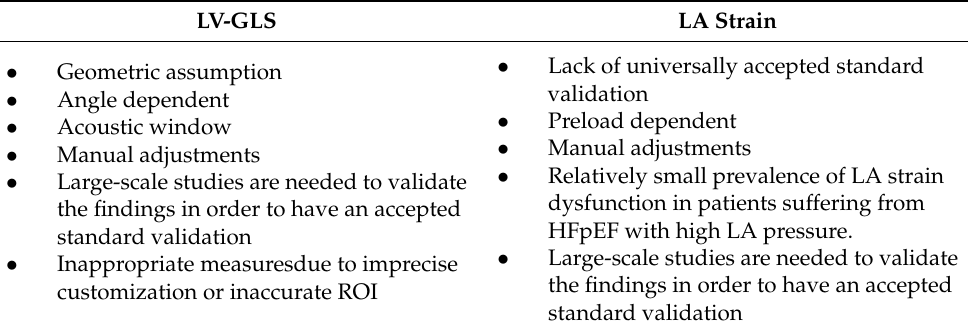
Table 2. Main limitations of strain analysis in LV, RV and LA